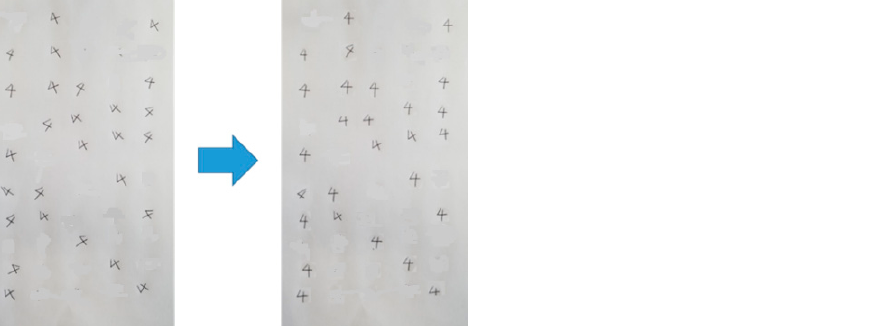
Figure 17. Tilt correction examples of “4” following the proposal ( left : original, right : tilt correction results).